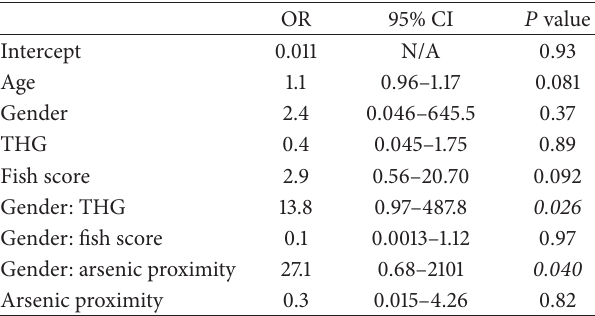
Table 3: Point estimates and 95% confidence intervals (CI) for coefficients and odds ratios (OR) for fitting logistic regression models for ANA ≥